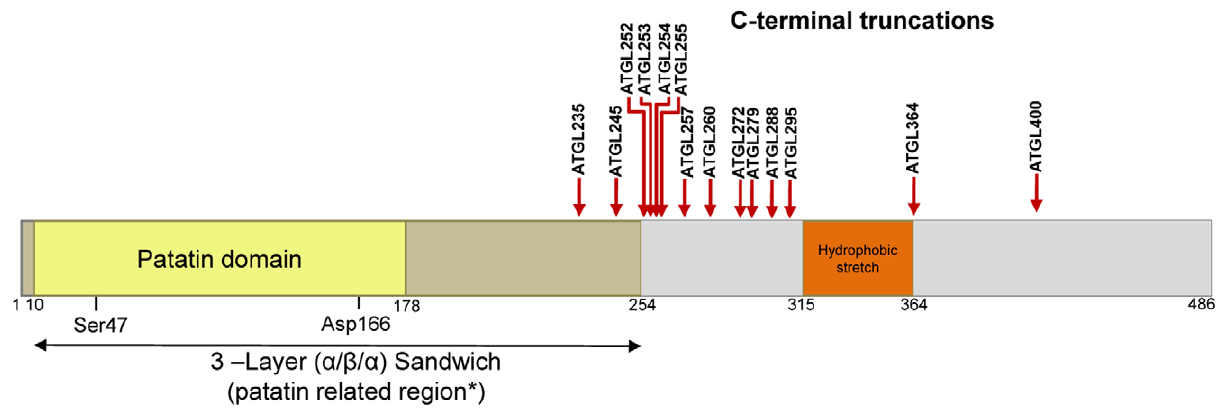
Figure 1. Domain organization of mouse ATGL and C-terminal truncations used in this study. Graphical representation of the predicted domain organization: in light yellow: patatin domain (residues 10–178), including the residues forming the proposed catalytic dyad (Ser47 and Asp166). Dark yellow: the 3-layer ( a / b / a ) sandwich (residues 10–254); Orange: the putative hydrophobic region. Red arrows indicate the 14 C-terminal deletions which were used in this study. *as shown in this